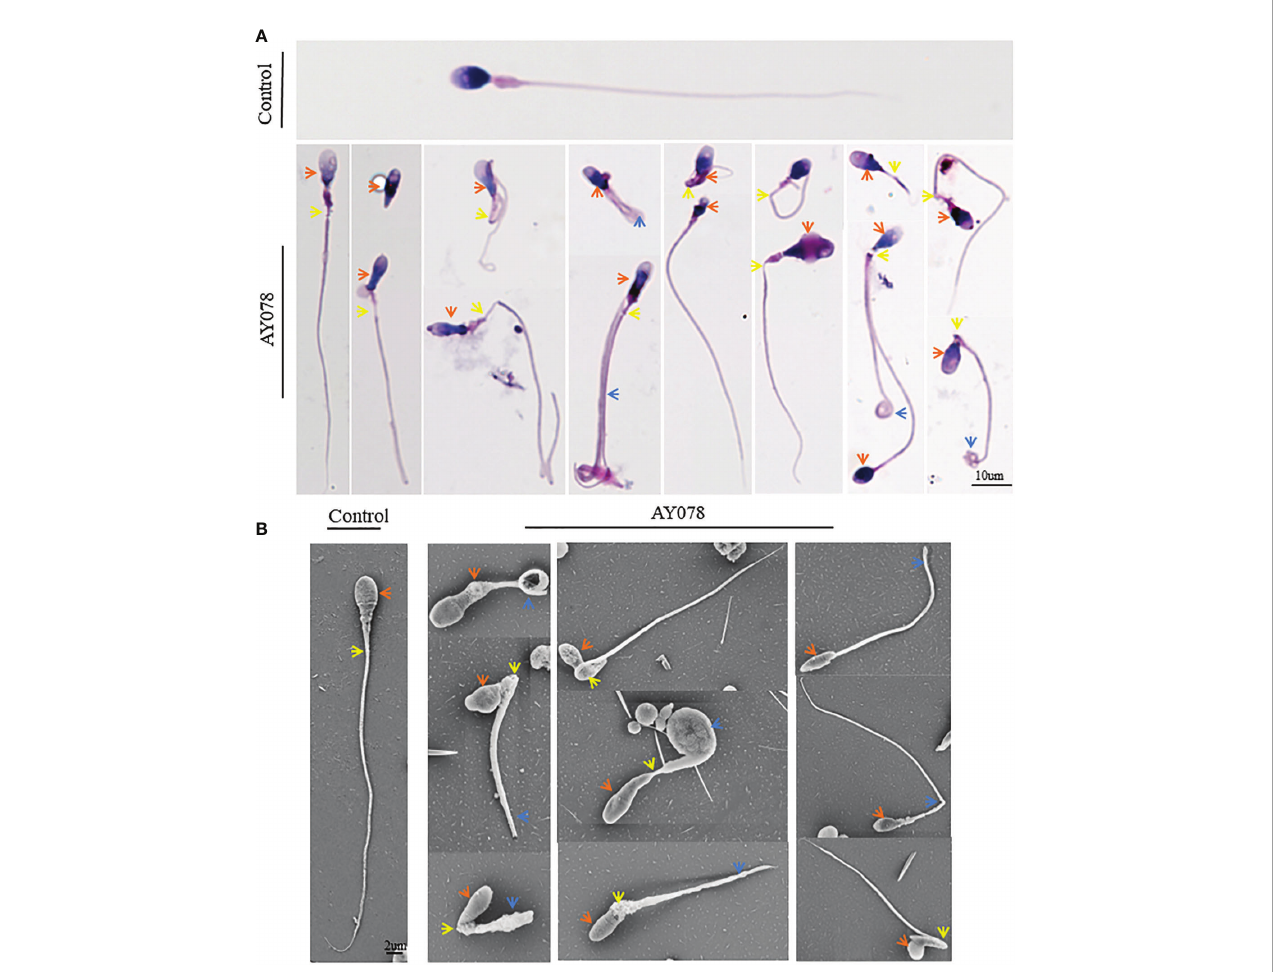
FIGURE 2 Morphology analysis of sperm from HYDIN -de fi cient patient AY078. (A, B) Morphology analysis showed various defects in head, neck and fl agella of sperm from AY078 via H&E staining and SEM. Comparing with normal-shaped head that nucleus capped by acrosome, long and smooth fl agella in control spermatozoa, the amorphous head, pyramid head and abnormal acrosome (orange arrowhead), the short and coiled fl agella were observed in P1. Scale bar: 10 m m in (A) , 2 m m in (B)